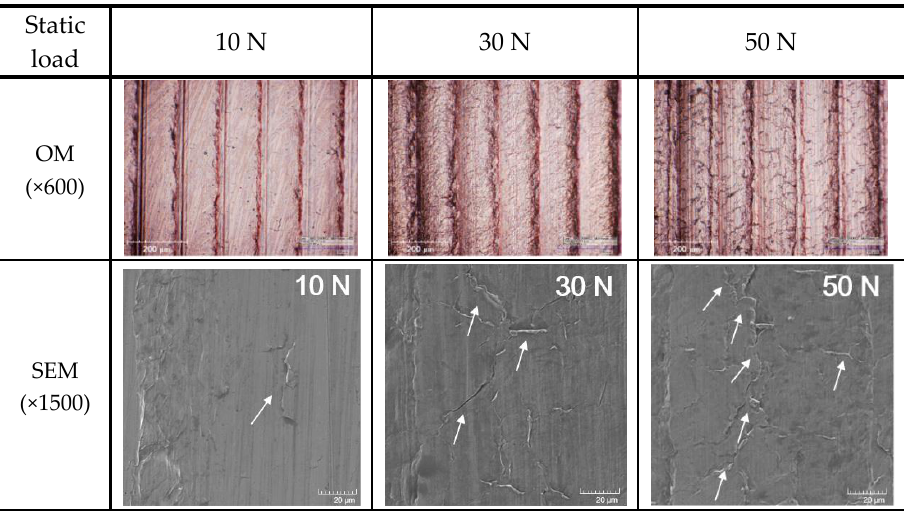
Figure 15. The effect of the static load over the critical UNSM condition on the corrosion factors of Alloy 600.